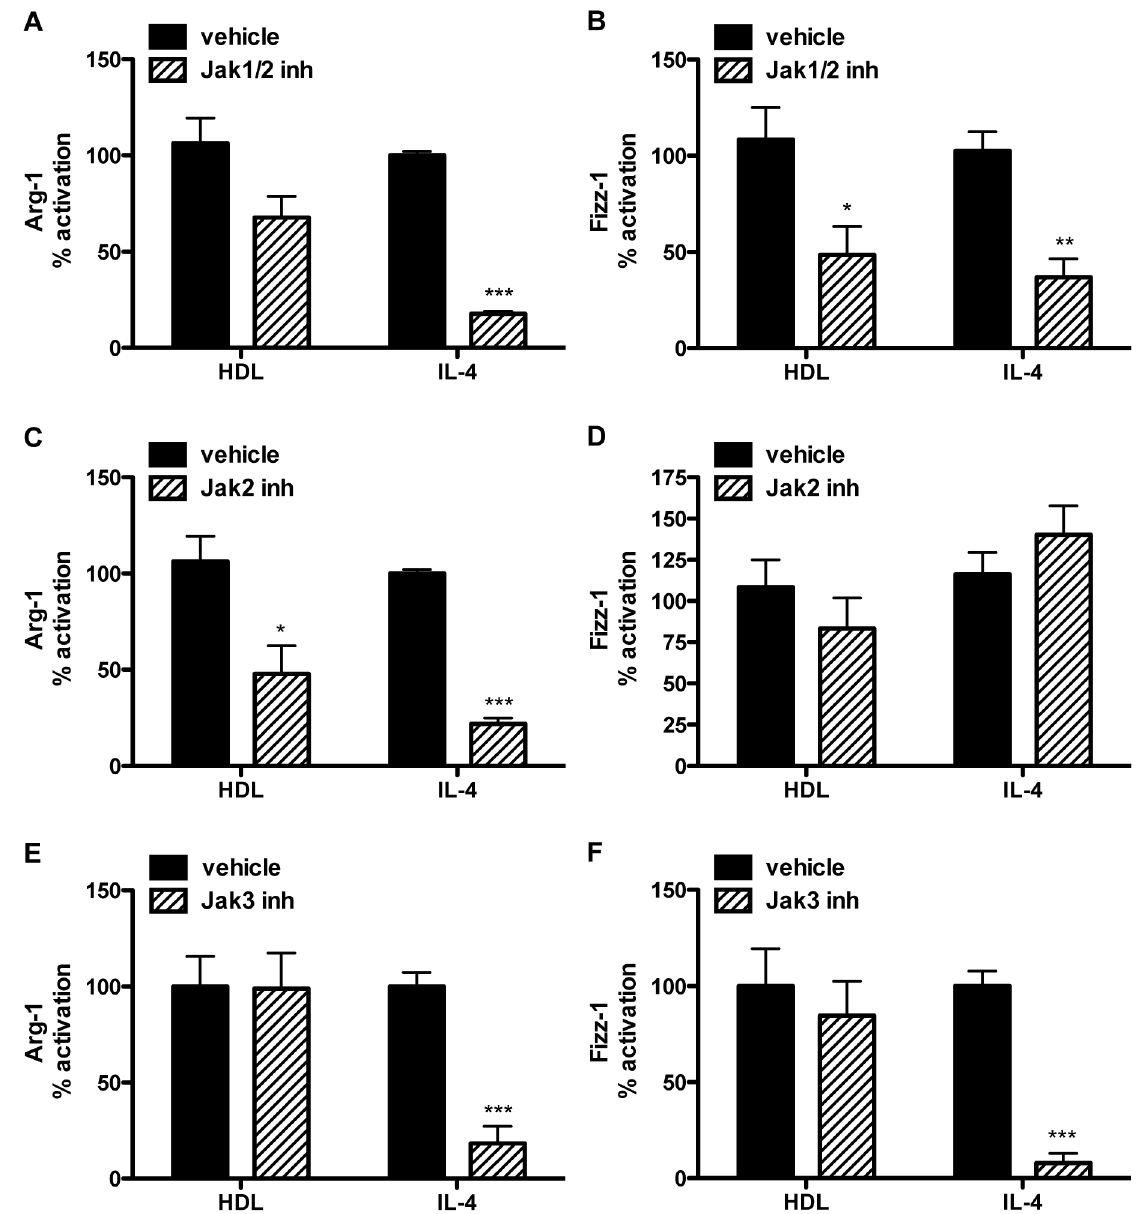
pharmacological inhibitors (hatched bars. Ruxolitinib/Jak1/2 inhibitor: 1μM. TG101348/Jak2 inhibitor: 1μM: Kaempferol/Jak3 inhibitor: 40μM) or vehicle (black bars), and then treated for 6h with HDL (50μg/mL) or IL-4 (10ng/mL). Arg-1 (A, C, E) and Fizz-1 (B, D, F) expression are presented as the percentage of activation compared to non-inhibited conditions. The induction of Arg-1 and Fizz-1 by HDL was ~2X for each, and for IL-4 was >300 for Arg-1 and Fizz-1 and these values were set to 100%. Results are representative of three independent experiments. Asterisks indicate statistically significant differences compared to the vehicle- treated conditions (*p<0.05, **p<0.01, ***p<0.001).